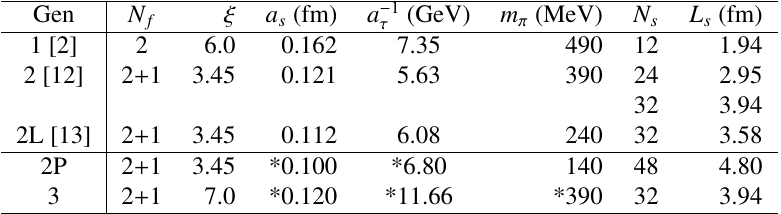
Table 1. FASTSUM ensemble parameters: number of flavours N f , spatial lattice spacing a s , inverse , anisotropy ξ = a s / a τ , pion mass m π , number of lattice sites L s in the temporal lattice spacing a − 1 τ spatial directions and spatial extent L s . The Gen2P and Gen3 ensembles are in preparation (see section 4) and the starred numbers are target or expected